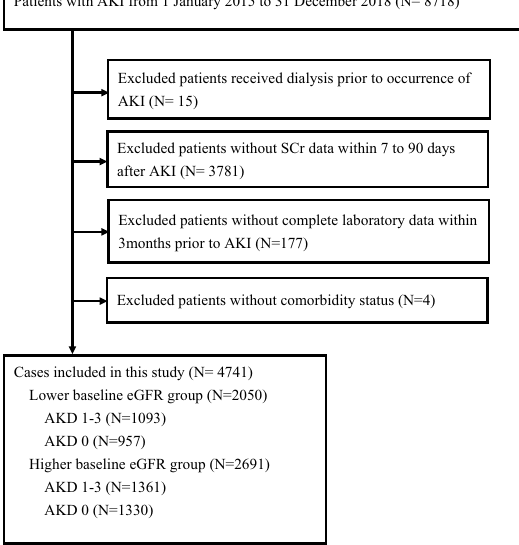
Figure 2. Flowchart demonstrating the inclusion of eligible patients. Flowchart demonstrates the selection criteria and process of eligible acute kidney injury patients for investigating the risk of major adverse kidney events. AKI acute kidney injury, SCr serum creatinine, eGFR estimated glomerular filtration rate, AKD acute kidney